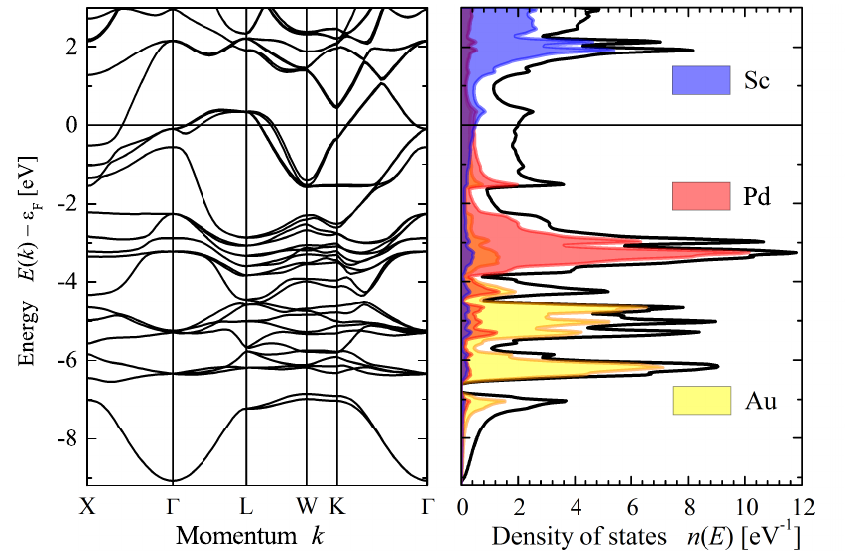
Figure 2. Electronic structure of AuPdScAl. The figure shows the band structure and density of states calculated with W IEN 2k [32], including the spin–orbit interaction. The total density of states is displayed by the black